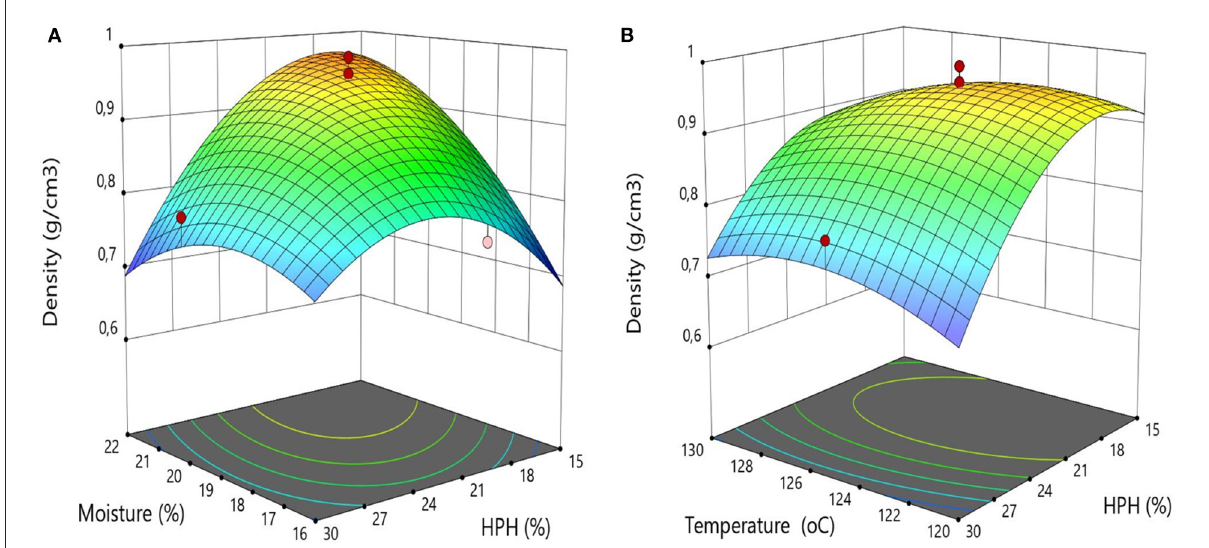
FIGURE3 Effect of HPH, moisture and temperature on EI. (A) Moisture vs. HPH (temperature 125 ◦ c and screw speed 220 RPM). (B) HPH vs. temperature (screw speed 220 RPM and moisture